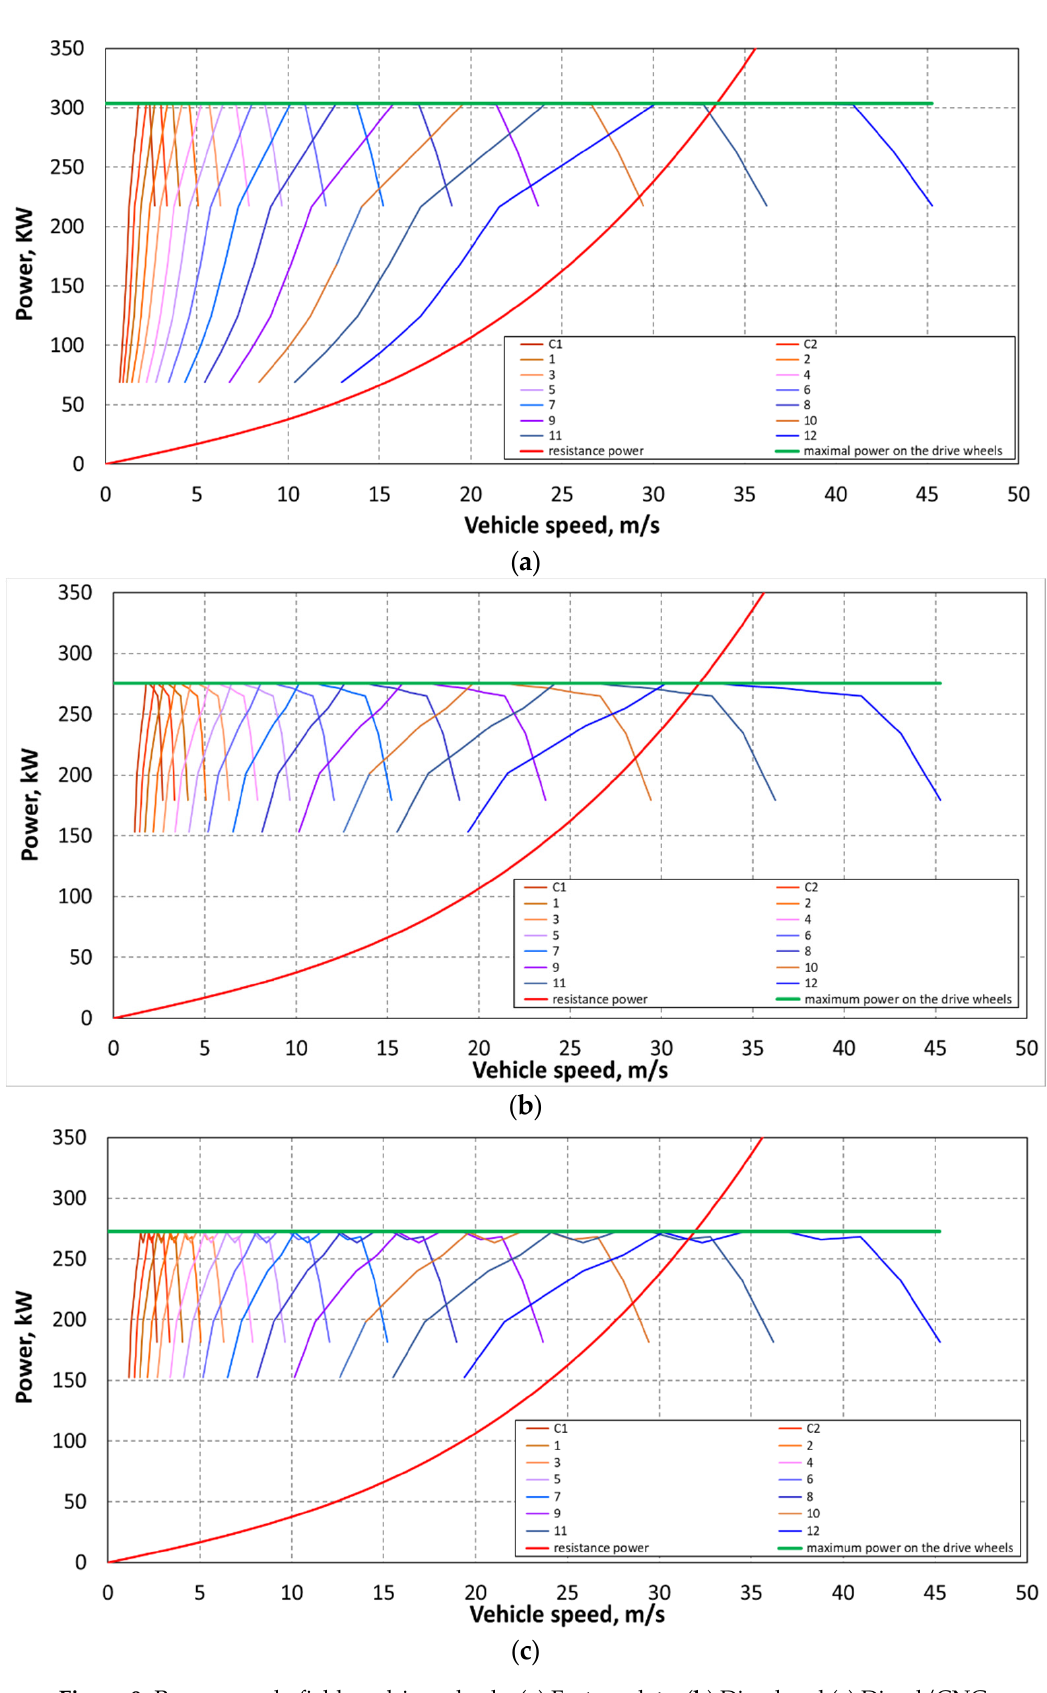
Figure 9. Power supply field on drive wheels. ( a ) Factory data, ( b ) Diesel and ( c ) Diesel/CNG.